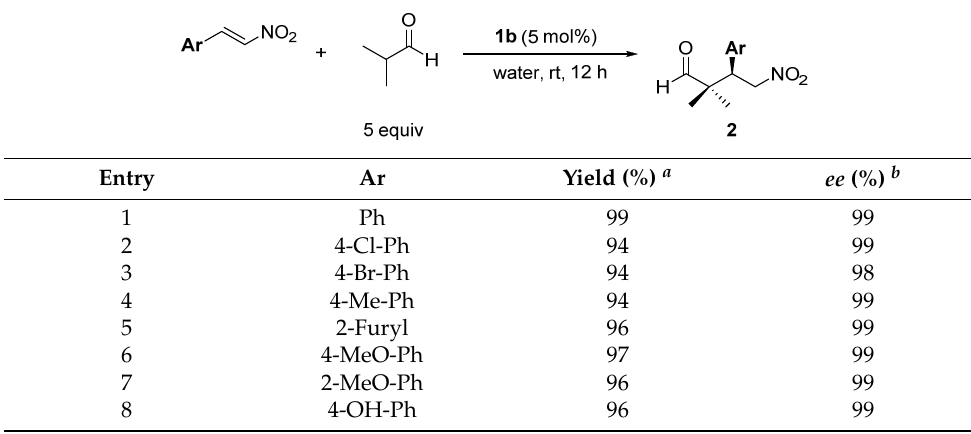
Table 3. Asymmetric Michael additions of aldehyde to nitro-olefins.